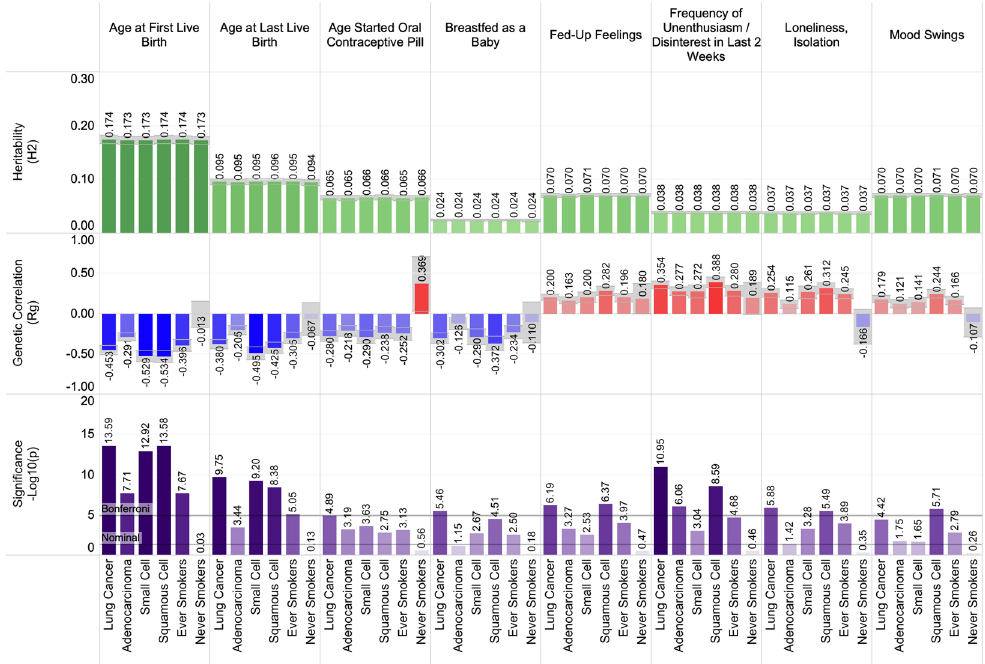
Figure 5. The shared heritability and genetic correlation between psychosocial and other specific traits with lung